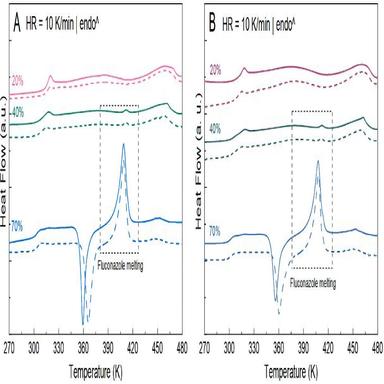
Thermograms obtained for tablets made from 20 %, 40 %, and 70 % fluconazole-loaded fresh (panel A) and 12-months old filaments (panel B). Solid lines represent thermograms of freshly printed 3D tablets, while dash lines reflect thermograms of 3D tablets stored for 14 days.